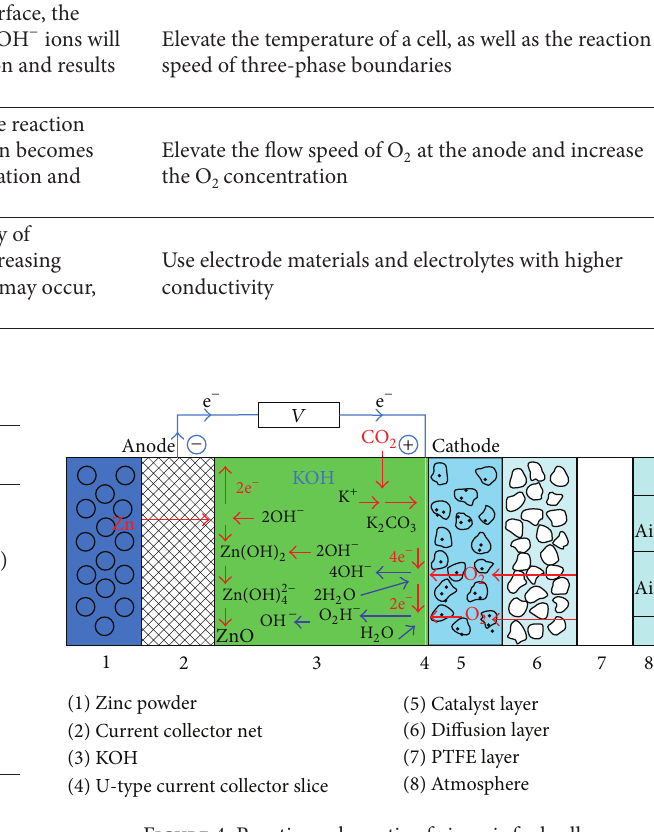
Figure 4: Reaction schematic of zinc-air fuel